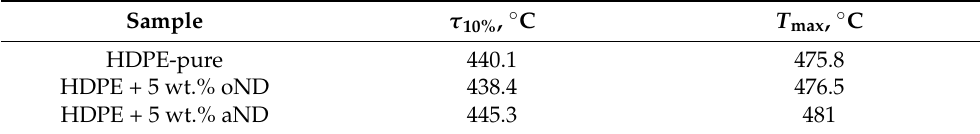
Table 3. The values of the temperature of the beginning of the weight loss of the samples ( τ 10% ) and the temperature of the maximum degradation rate ( T max ) for the oriented composite fibers based on HDPE.